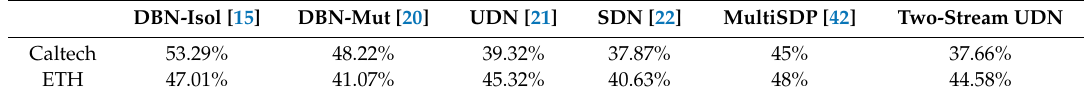
Table 3. LAMR of two-stream UDN and shallow